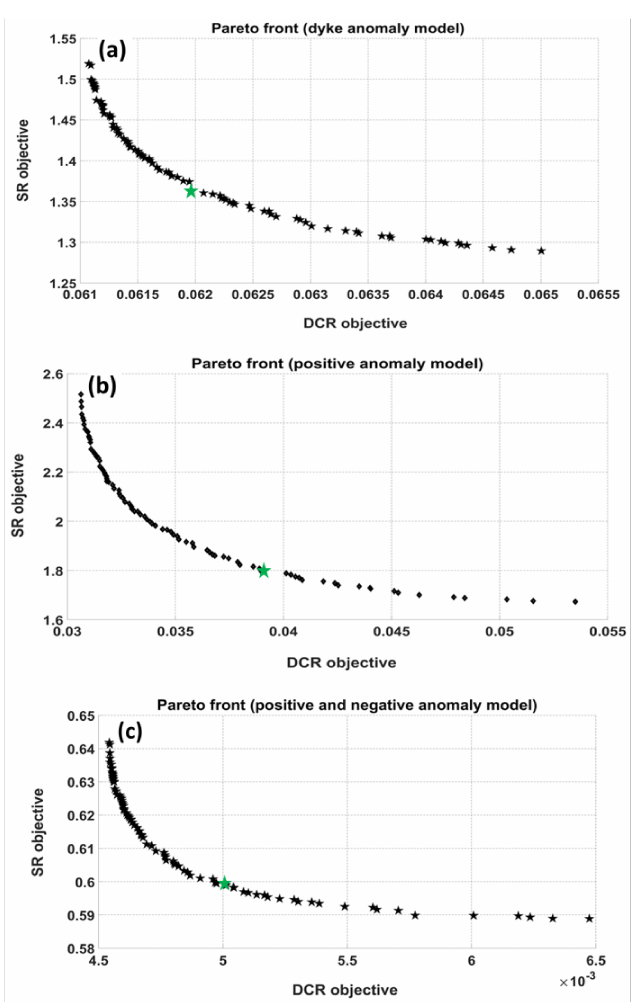
Figure 4. Plots of the Pareto fronts showing the compromise solution (green star shape) for ( a ) a dyke anomaly model, ( b ) a positive anomaly model, and ( c ) positive and negative anomalies